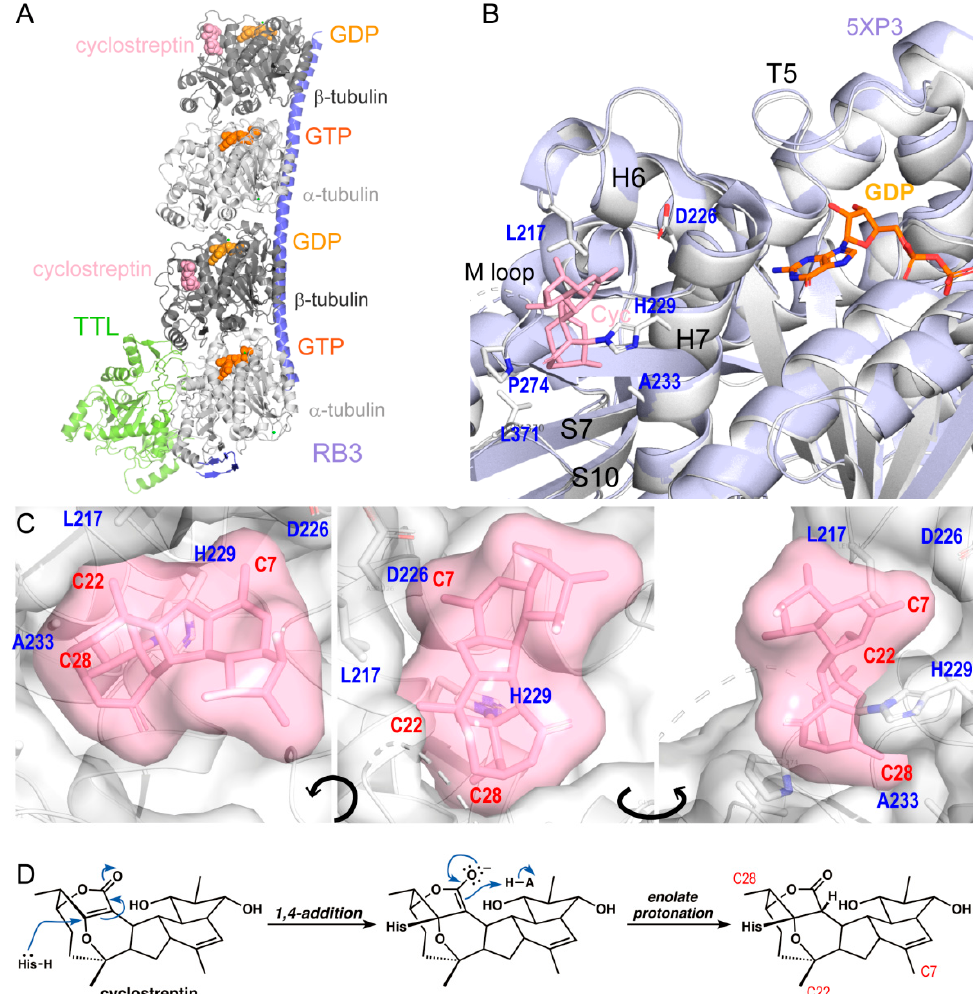
Figure 2. X-ray structure of the tubulin–cyclostreptin complex. ( A ) Overall view of the T 2 R–TTL–cyclostreptin complex (6QTN). Tubulin (gray), RB3 (blue) and tubulin tyrosin ligase (TTL) (green) are shown in ribbon representation. Cyclostreptin (pink) is depicted in sphere representation, and the nucleotides of α and β tubulin are shown in orange spheres. ( B ) Close-up view of the taxane and nucleotide sites of GDP-bound β -tubulin in the complex (gray ribbon) with cyclostreptin (pink sticks) bound to β His229, superimposed with guanosine triphosphate (GTP)-bound β -tubulin (5XP3) (cyan ribbon). ( C ) Surface representation of the taxane binding site with cyclostreptin (pink sticks) bound. ( D ) Mechanism of the reaction between cyclostreptin and β His229.